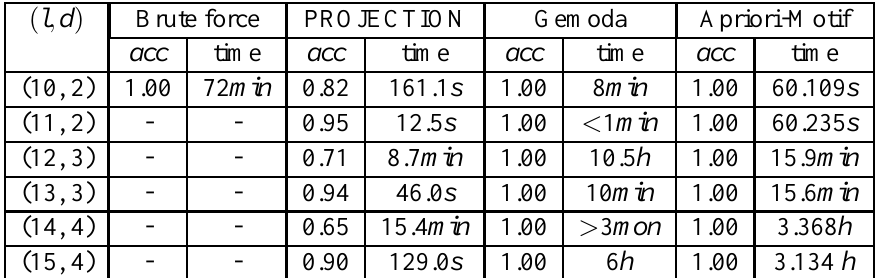
Table 1: The Performance Comparison on a Range of ( l , d )